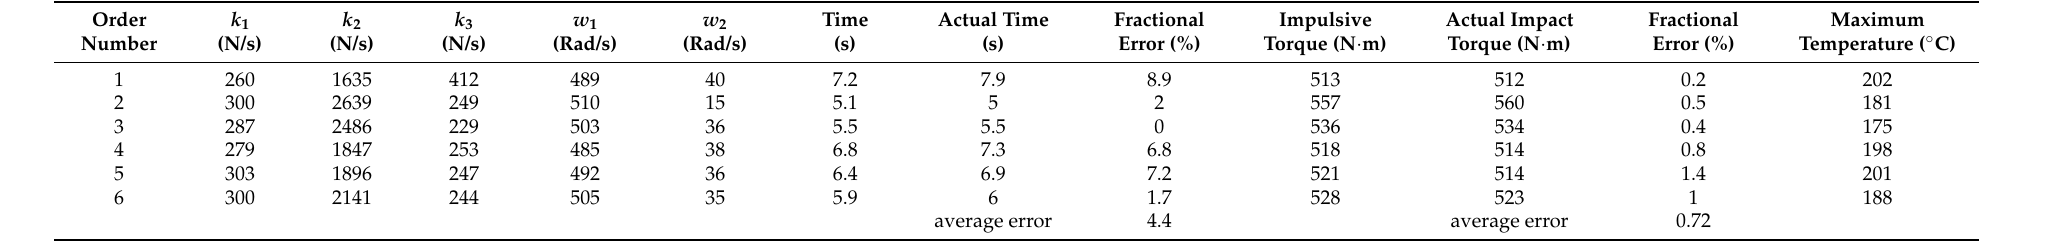
Table 6. Multi-objective optimization validation